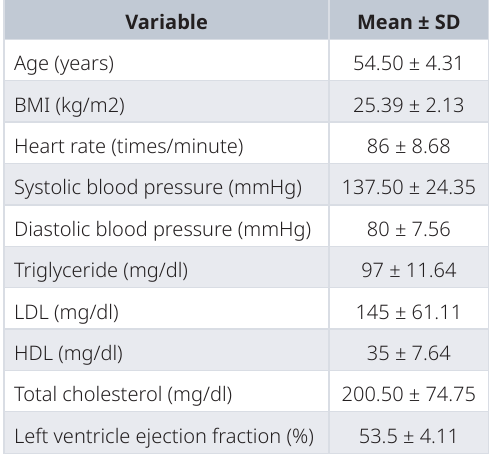
Table 1. The characteristics of the study